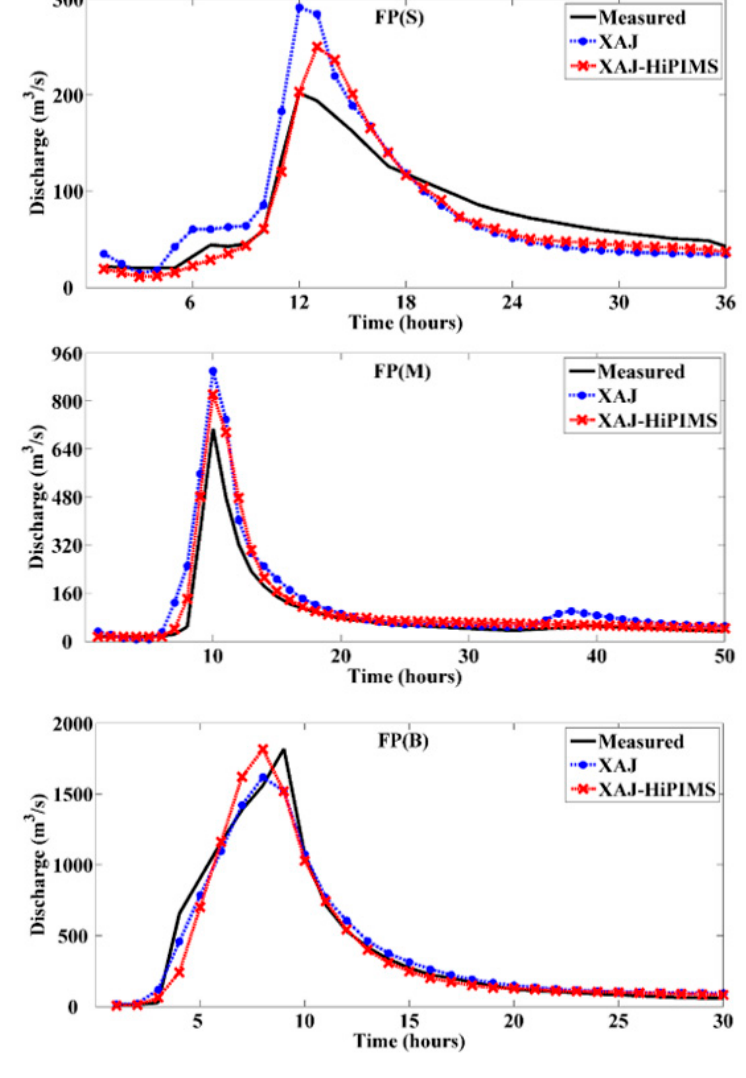
Figure 5. Time history of discharge at the outlet gauging station.